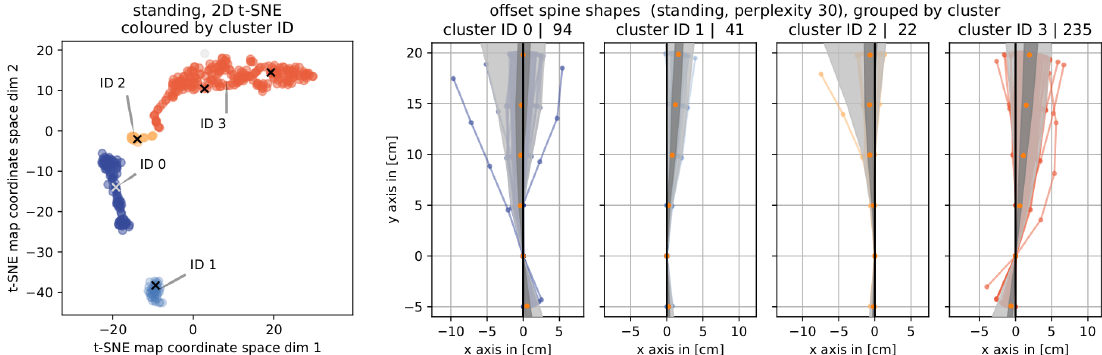
Figure A1. Results for clustering posture pairs of standing . ( left ) The t-SNE map labelled with and colored by cluster ID. An ‘x’ marks the position of a cluster representative. ( right ) Corresponding cluster bundles of offset spine shapes